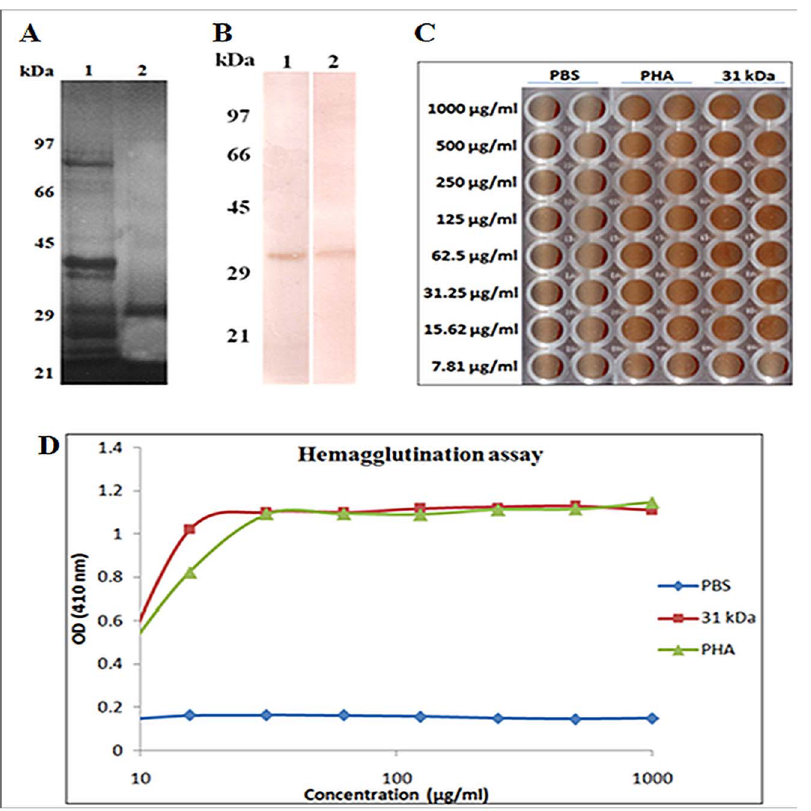
Figure 4. Glycoprotein detection by Periodic Acid Schiff’s (PAS) staining. Lane 1: kidney bean extract, lane 2: purified 31 kDa protein (A). Immunoblot of purified protein after periodate treatment. The 31 kDa protein was electro-transfered onto nitrocellulose membrane and then periodate oxidation was done. The strip was washed, blocked with 3% defatted milk and immunoblotted with pooled patients’ sera. Lane 1: 31 kDa protein (untreated), lane 2: 31 kDa protein after periodate treatment (B). Hemagglutination assay of 31 kDa protein, PHA (positive control) and PBS (negative control). Both 31 kDa and PHA formed uniform reddish color across the well with a minimum concentration of 15.62 m g/ml (C). Agglutination of human erythrocytes using purified protein and PHA (Sigma)